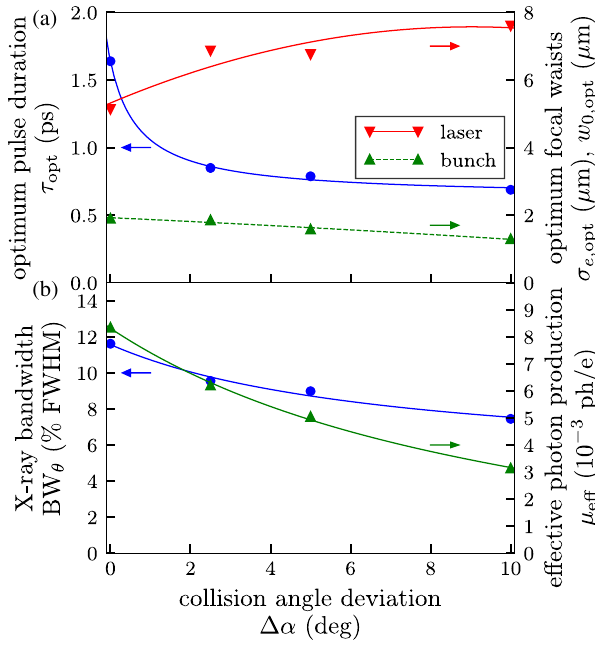
FIG. 8. Deviation from the head-on geometry. (a): Optimized laser and bunch parameters. (b): Effective photon production (green) and cone bandwidth (blue). Markers display the simu- lation results, lines represent fits through the data. A reciprocal function is fitted to τ , BW θ and μ . The other fits are second- eff degree